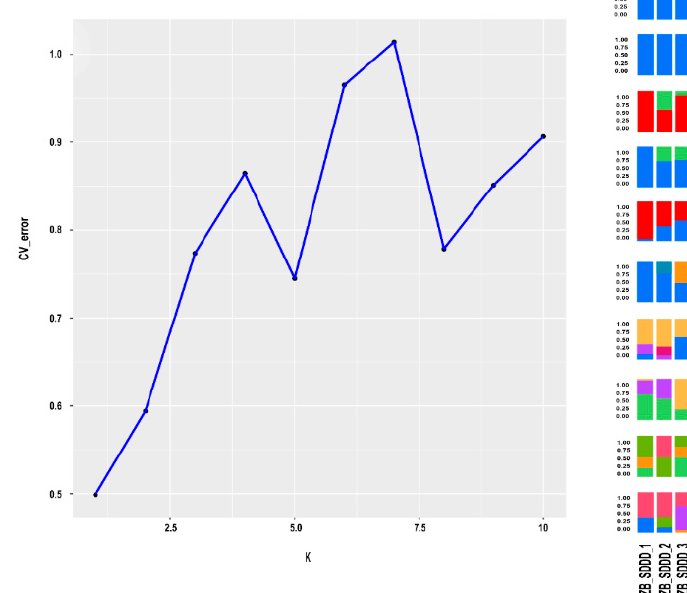
Figure 4. Phylogenetic tree of 30 L. kasmira individuals based on SNP loci created using the neighbor- joining method.